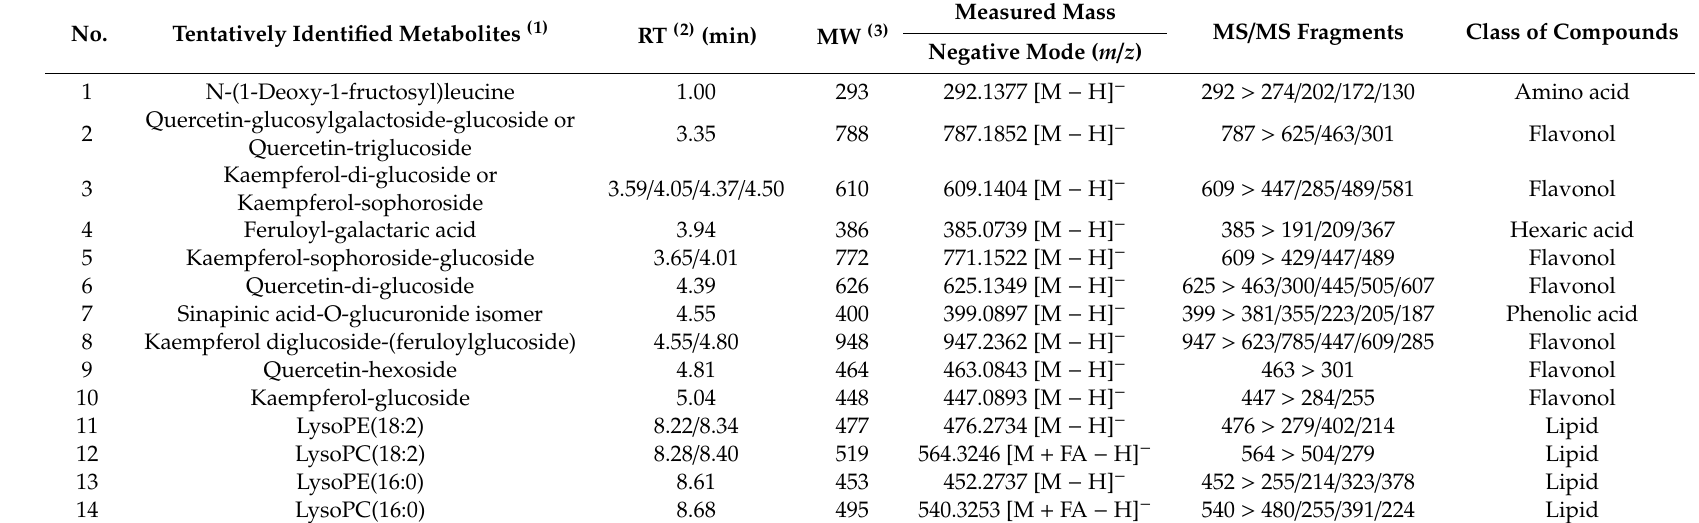
Table 6. Tentatively identified metabolites in CC juice based on the UHPLC-LTQ-Orbitrap-MS / MS